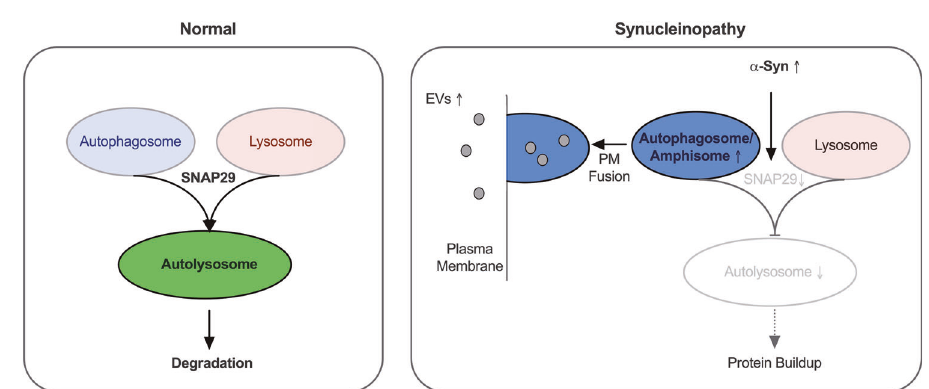
Fig. 7 The abundance of SNAP29 is stage-dependently decreased in neuromelanin-positive neurons from LBP cases. a Representative photomicrograph from immunohistochemical staining of SNc post-mortem brain tissue at a low magni fi cation (bar: 200 μ m). Bright fi eld images indicate neuromelanin pigment (black) in SNc DA neurons. Tissue sections were stained with an antibody against SNAP29 (green) and human α -Syn (blue), revealing a cytoplasmic staining pattern for SNAP29 in neuromelanin-positive neurons. 1st row: pictures from a control case, that had no LBP, 2nd to 4th row: pictures from cases that has LBP at different Braak stages. b Representative photomicrograph from immunohistochemical staining of SNc post-mortem brain tissue at a high magni fi cation (bar: 25 μ m) from healthy control cases (1st row) and from cases that has LBP at different Braak stages (2nd to 4th row). Tissue sections were stained with an antibody against SNAP29 (green), revealing a cytoplasmic staining pattern for SNAP29 in neuromelanin-positive neurons. Note a stage-dependent decrease of cytoplasmic SNAP29 fl uorescence in LBP, whereas control neurons show a clear cytoplasmic SNAP29 fl uorescence signal. c Bar graph illustrating the average abundance of SNAP29 in LBP cases including all Braak stages (1 – 6). The average fl uorescence signal was analyzed per case ( n of cases per condition; control: n = 6; Braak stage 1: n = 3; Braak stage 3: n = 2; and Braak stage 6 n = 6) d Bar graph illustrating a drop of SNAP29 in LBP cases. Different from c , the fl uorescence signal was analyzed and computed in each neuromelanin-positive cell individually ( n of cells per condition; control: n = 679; Braak stage 1: n = 440; Braak stage 3: n = 381; and Braak stage 6 n = 612), demonstrating a stage-dependent decline of SNAP29 fl uorescence in SNc DA neurons of LBP cases. e Graph illustrating the correlation of the SNAP29 and α -Syn fl uorescence signal in individual SNc neurons ( n = 352 cells). For comparison of the means, a two-tailed unpaired t -test was used in panel c ; a one-way ANOVA with Š idák ’ s test for multiple comparisons was used in panel d . A linear regression was calculated in panel e . *** P < 0.005, * P < 0.05. Data are shown as means ± SEM.